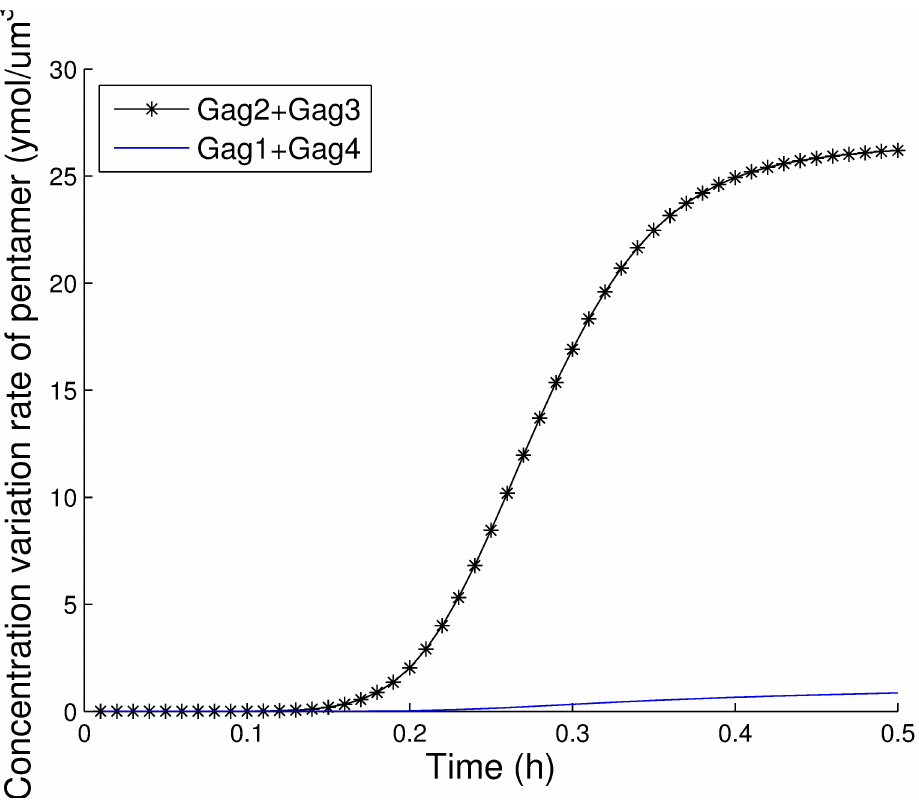
Fig 11. The contributions of two pathways to form